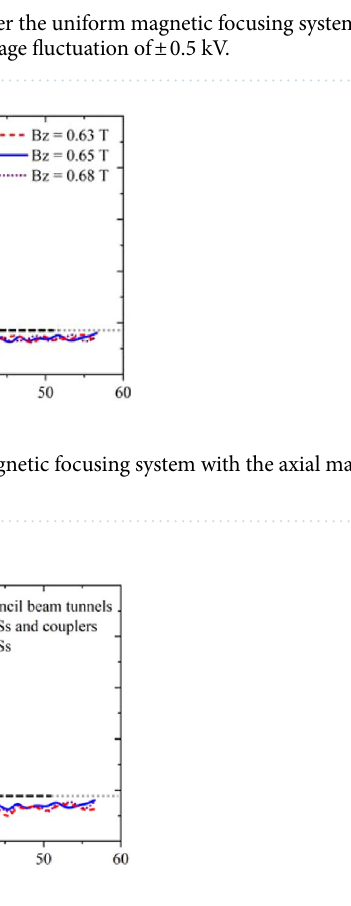
Figure 21. Simulation of the beam current under the uniform magnetic focusing